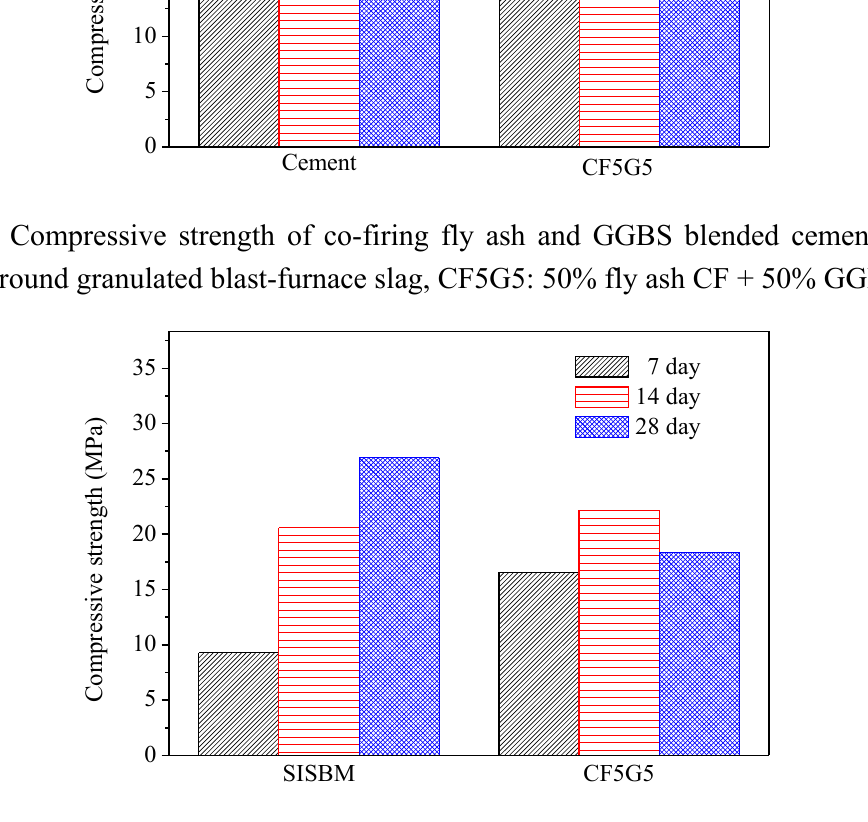
Figure 5. Compressive strength of SISBM and CF5G5 blended cement mortar. (SISBM: steel and iron slag blended material, CF5G5: 50% fly ash CF + 50%